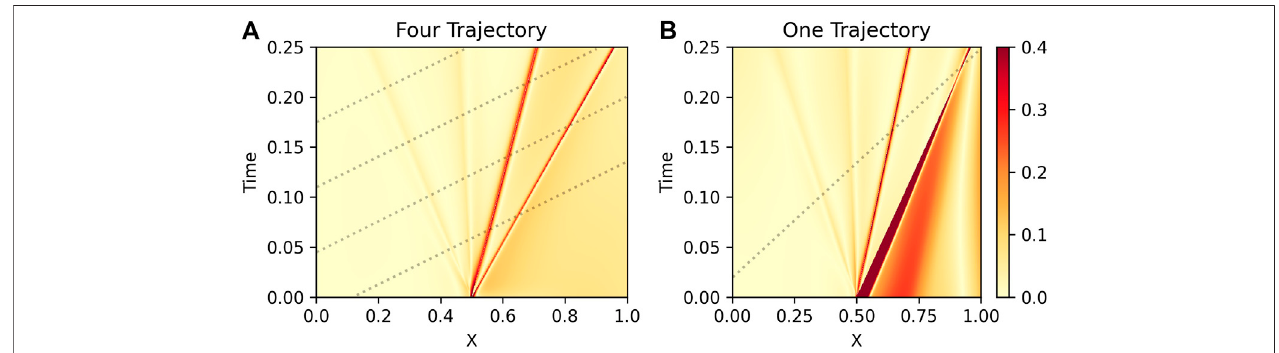
FIGURE3|(A) :DensityRelativeError (cid:3) ( ρ net − ρ )/ ρ (cid:3) foraPINNtrainedwithfoursampledtrajectories(dottedlines)ontheSodshocktube.Thegreatesterrorisalong the shock wave (second from right); the PINN does not handle abrupt gradients well. (B) : Same, but for case of a PINN trained on one sampled trajectory. The PINN struggles to recover the solution further away from the boundary data.